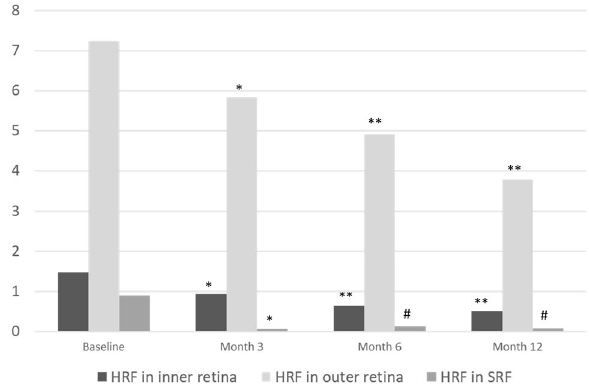
Figure 2. The average number of HRF in different retinal layers at the baseline and 3, 6, 12 months after anti- vascular endothelial growth factor treatment for diabetic macular oedema. The number of HRF in every retinal layer significantly decreased in all follow up time points compared with baseline. HRF hyperreflective foci, SRF subretinal fluid. *p = 0.001 (compared with baseline). # p = 0.002 (compared with baseline). **p < 0.001 (compared with baseline).